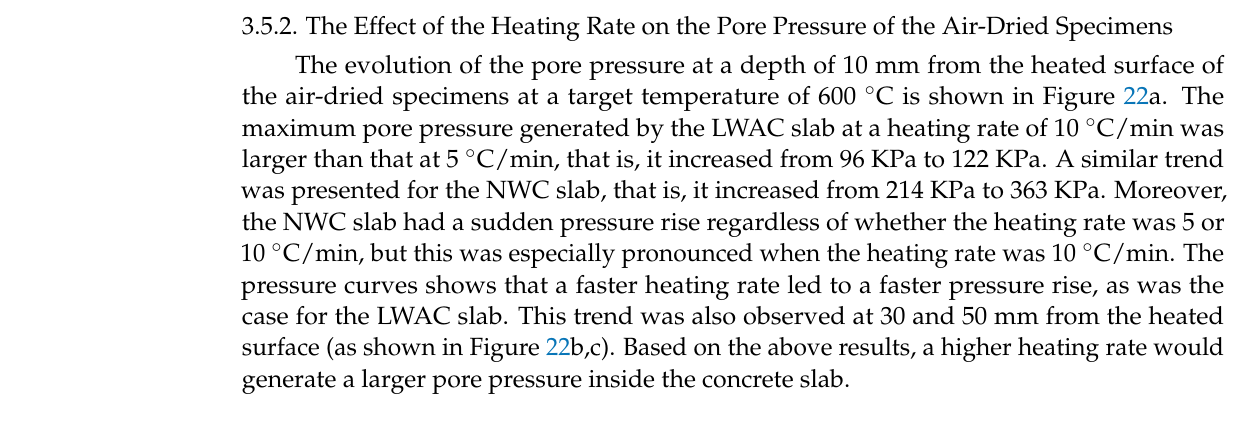
Figure 21. Effect of the heating rate on the pore pressure of the oven-dried specimens performed at a target temperature of 800 °C: ( a ) 10; ( b ) 30; ( c ) 50 mm depths. target temperature of 800 ◦ C: ( a ) 10; ( b ) 30; ( c ) 50 mm depths.